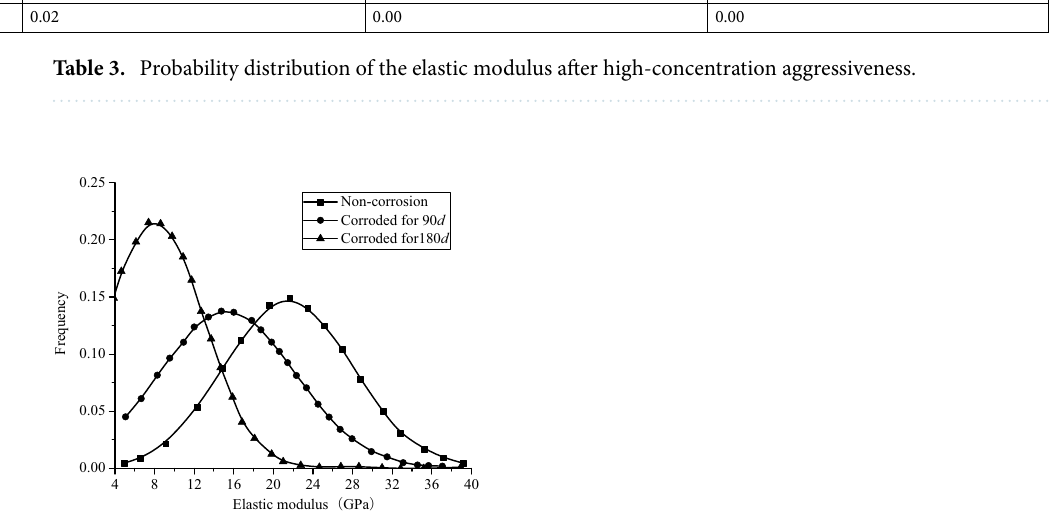
Figure 4. Probability fitting diagram of elastic modulus after high-concentration